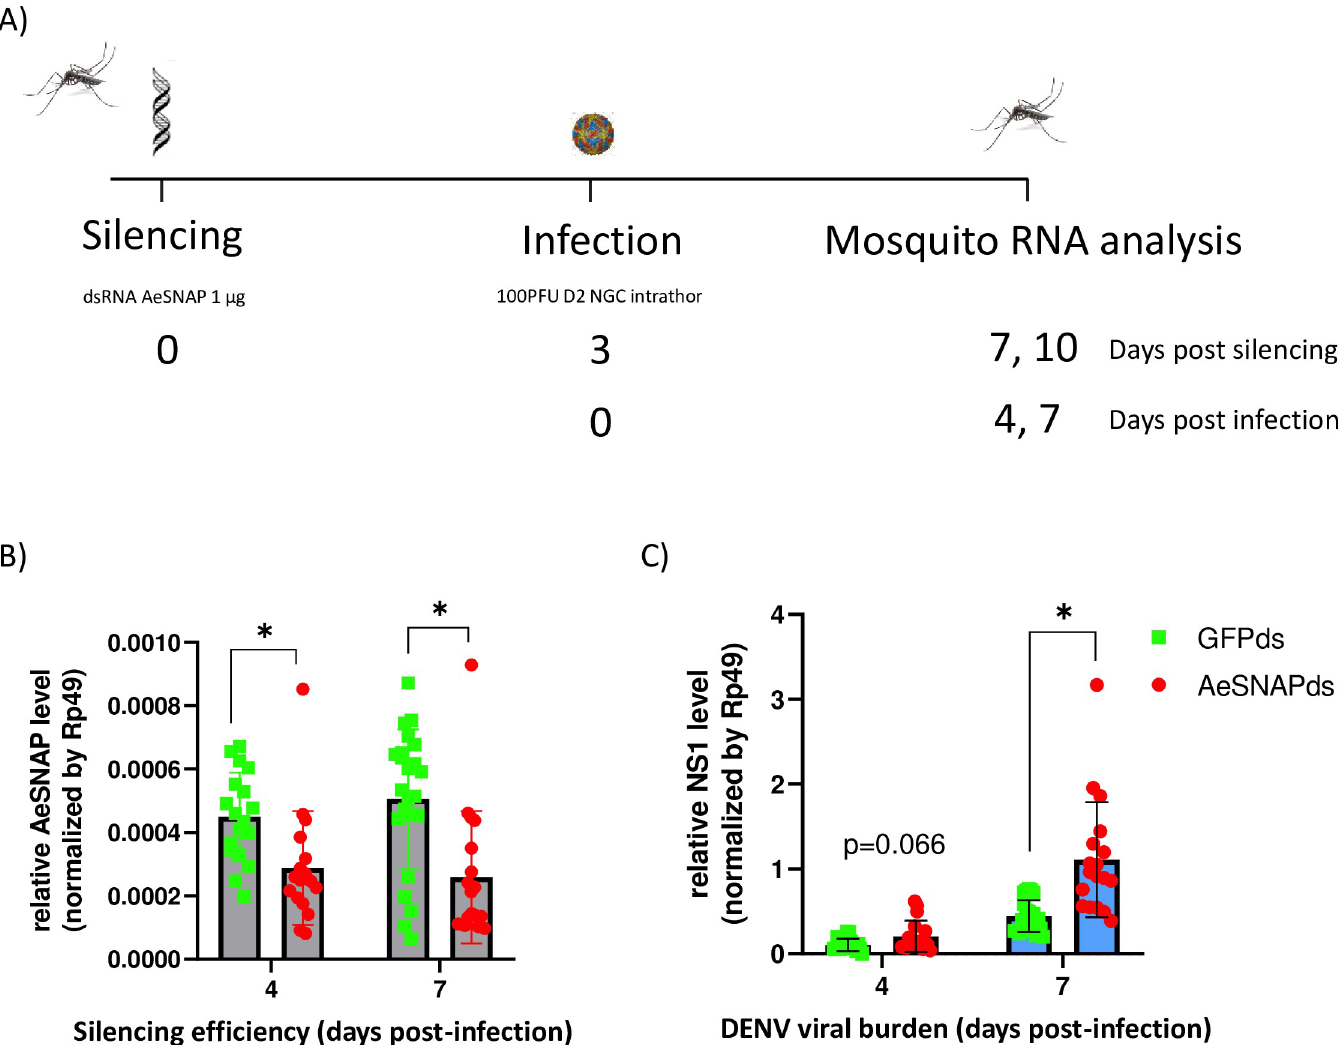
Fig 5. Dissemination analysis of DENV2 in AeSNAP dsRNA-knockdown mosquitoes. (A) Scheme of the strategy for dissemination studies in the Aedes mosquito. A . aegypti mosquitoes were intrathoracically injected with AeSNAP dsRNA, and at 72h, they were infected with 100PFU of DENV2 using the same route. Silencing efficacy and viral burden were evaluated at 4- and 7- day post infection. B) AeSNAP silencing efficacy (grey bars). (C) DENV2 viral load recovered from DENV2 infected A . aegypti mosquitoes (blue bars). AeSNAP and DENV2 RNA levels were analyzed by qRT-PCR and normalized to the levels of Rp49. Green squares correspond to GFP silenced mosquitoes (control) and red circles correspond with AeSNAP silenced mosquitoes. Results are representative of two independent experiments. Asterisks represent significant difference between samples, calculated by Mann-Whitney non-parametric test (p � 0.05).